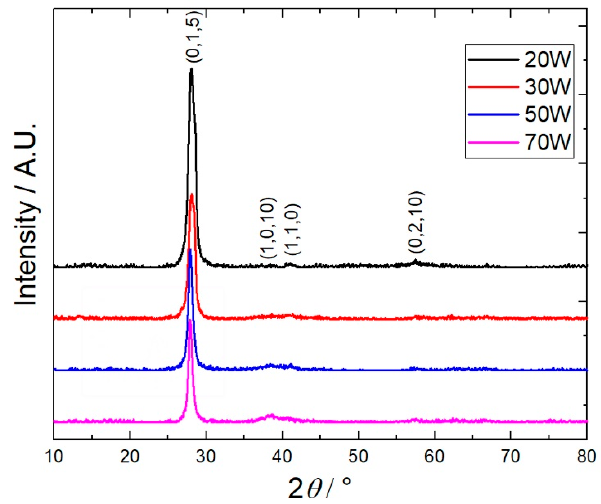
Figure 1. SEM images of the Bi 2 Te 3 films deposited under different powers